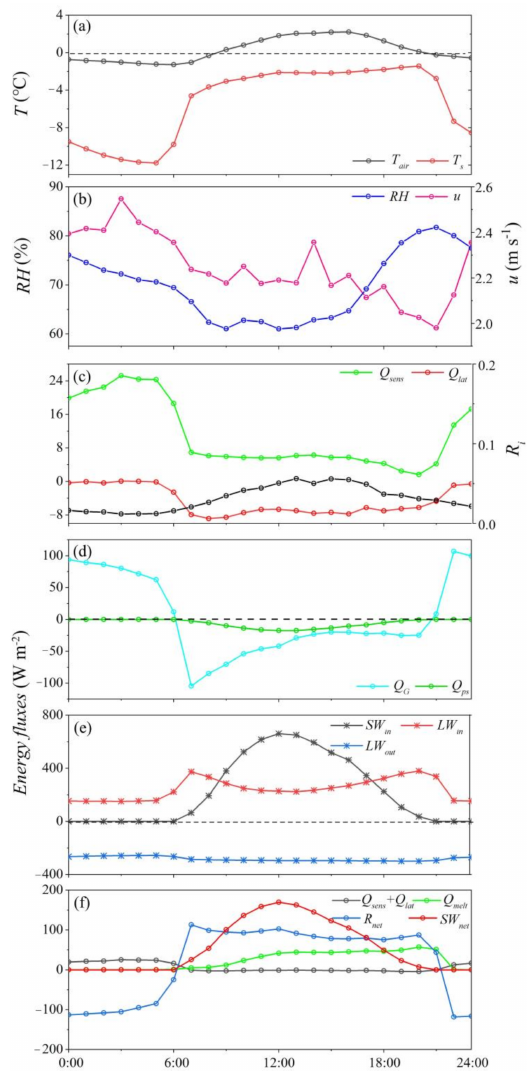
Figure 4. Mean diurnal cycle of ( a ) air temperature at 2 m above the surface and surface temperature, ( b ) relative humidity and wind speed at 2 m above the surface, ( c ) turbulent sensible and latent heat flux Qsens , Qlat and R i , ( d ) heat conduction flux ( Q c ) and penetrating shortwave radiation ( Q ps ), ( e ) downward shortwave radiation ( SW in ), incoming longwave radiation ( LW in ) and outgoing longwave radiation ( LW out ), ( f ) the turbulent heat fluxes ( Q sens + Q lat ), net radiation( R net ), net shortwave radiation ( SW net ) and heat flux for snow / ice melting ( Q melt ) of AWS1 on the east branch of UG1 during the ablation period from 29 April to 1 September